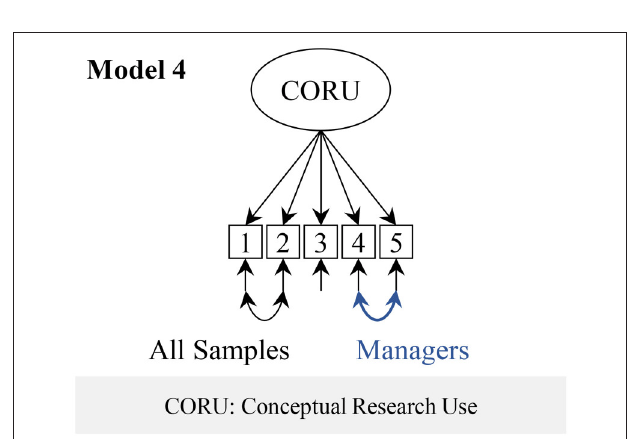
FIGURE 3 | Conceptual Research Utilization Scale factor models.